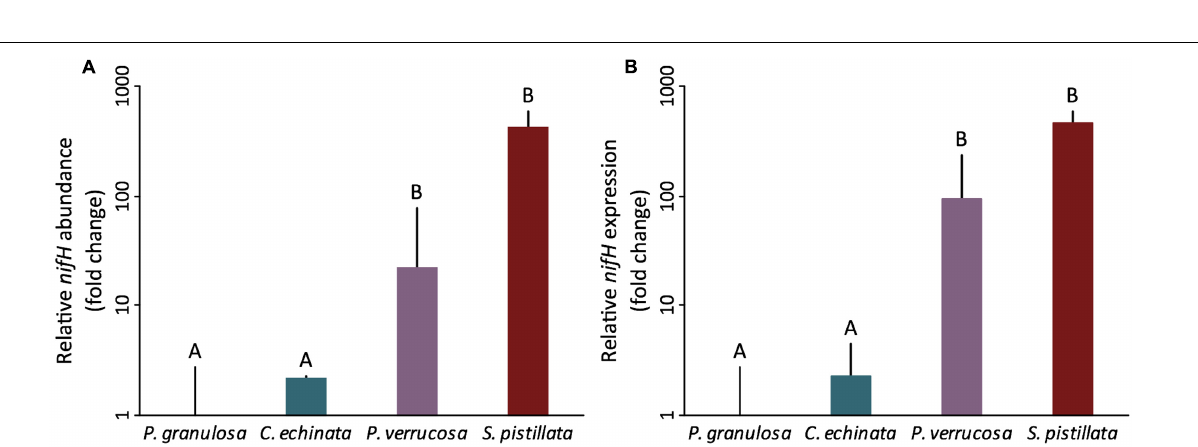
Frontiers in Microbiology |